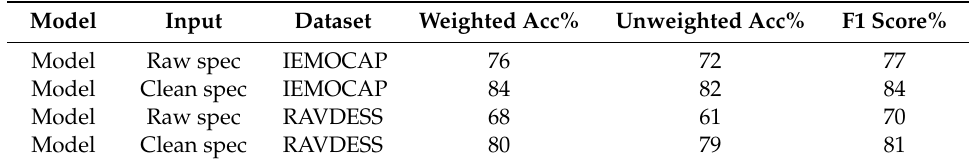
Table 1. Comparison of the proposed model, using raw spectrograms and clean